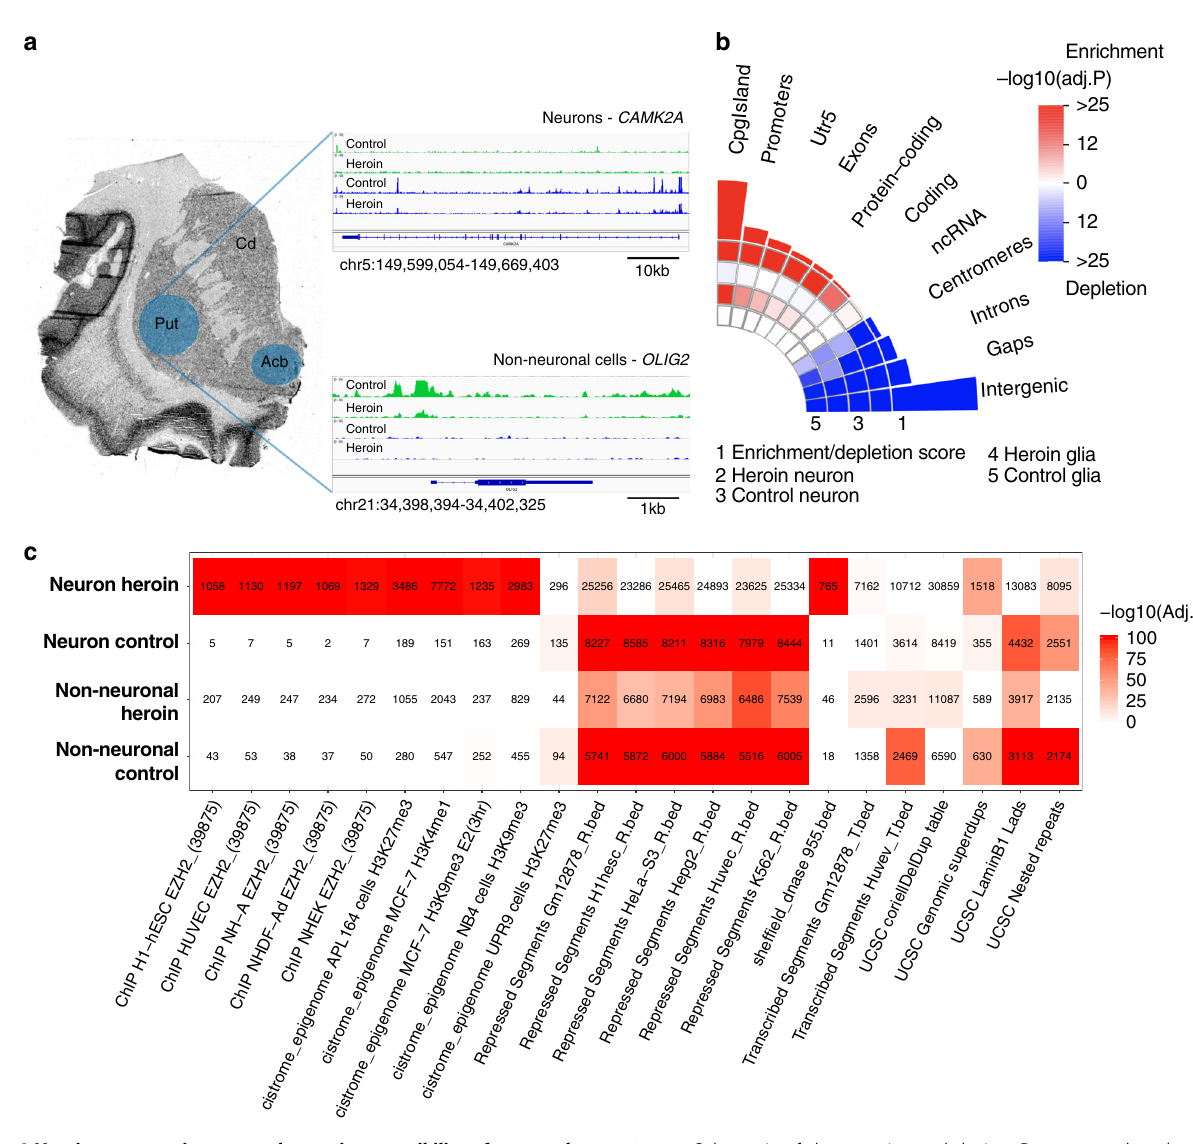
Fig. 1 Heroin exposure increases chromatin accessibility of neuronal promoters. a Schematic of the experimental design. Putamen and nucleus accumbens tissue (blue shades) was collected from post-mortem brains of human heroin users and controls. ATAC-seq was performed in FANS-sorted neuronal and non-neuronal (predominantly glial) cell populations ( n = 10/group). Neuronal cells (blue tracks) showed accessible regions at the CAMK2A gene but not at glial marker OLIG2 . Conversely, the OLIG2 locus but not the CAMK2A locus was accessible in non-neuronal cells (green tracks). b Neuronal ATAC peaks from heroin users were speci fi cally enriched in CpG islands, promoters and 5 ′ UTRs, whereas centromeres, introns, gaps, and intergenic areas were depleted across all groups (Fisher ’ s exact test, Benjamini – Hochberg correction). c Heat map showing the most enriched regulatory elements from ENCODE in neurons and non-neuronal cells from heroin users and control subjects. Neuronal ATAC peaks from heroin users were enriched for enhancer regions marked by H3K4me1 and EZH2 binding sites. Acb nucleus accumbens, Put putamen, Cd nucleus caudatus, utr untranslated region, ncRNA non- coding